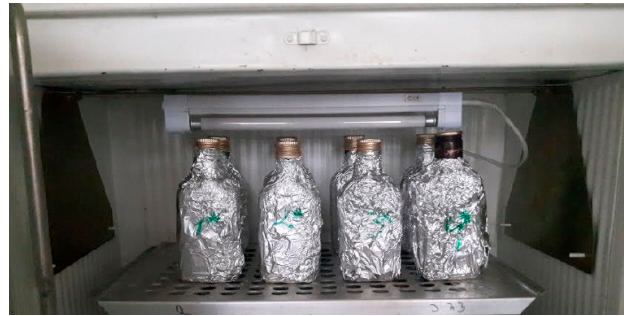
Figure 2. Position of oil samples in incubator.